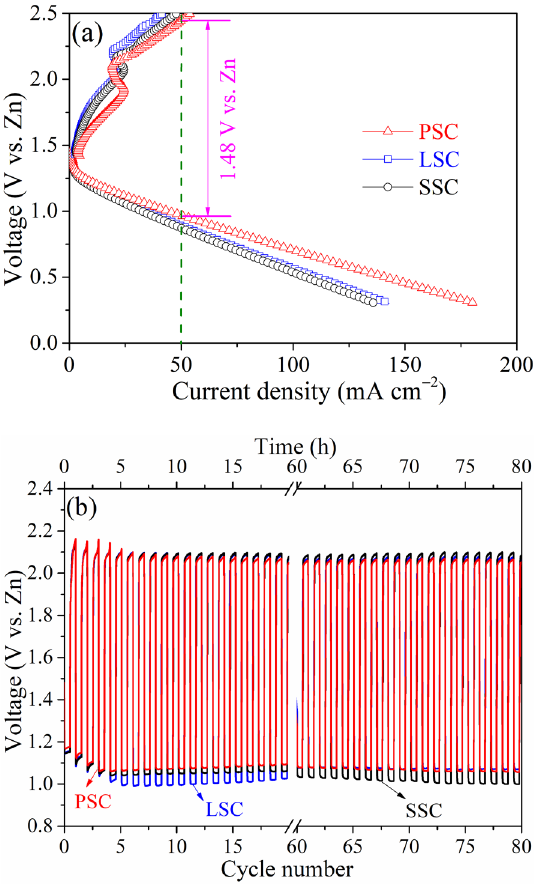
Figure 7. ( a ) Charge and discharge polarization curves; ( b ) Galvanostatic discharge-charge cycling curves at 10 mA cm −2 of rechargeable zinc–air batteries.